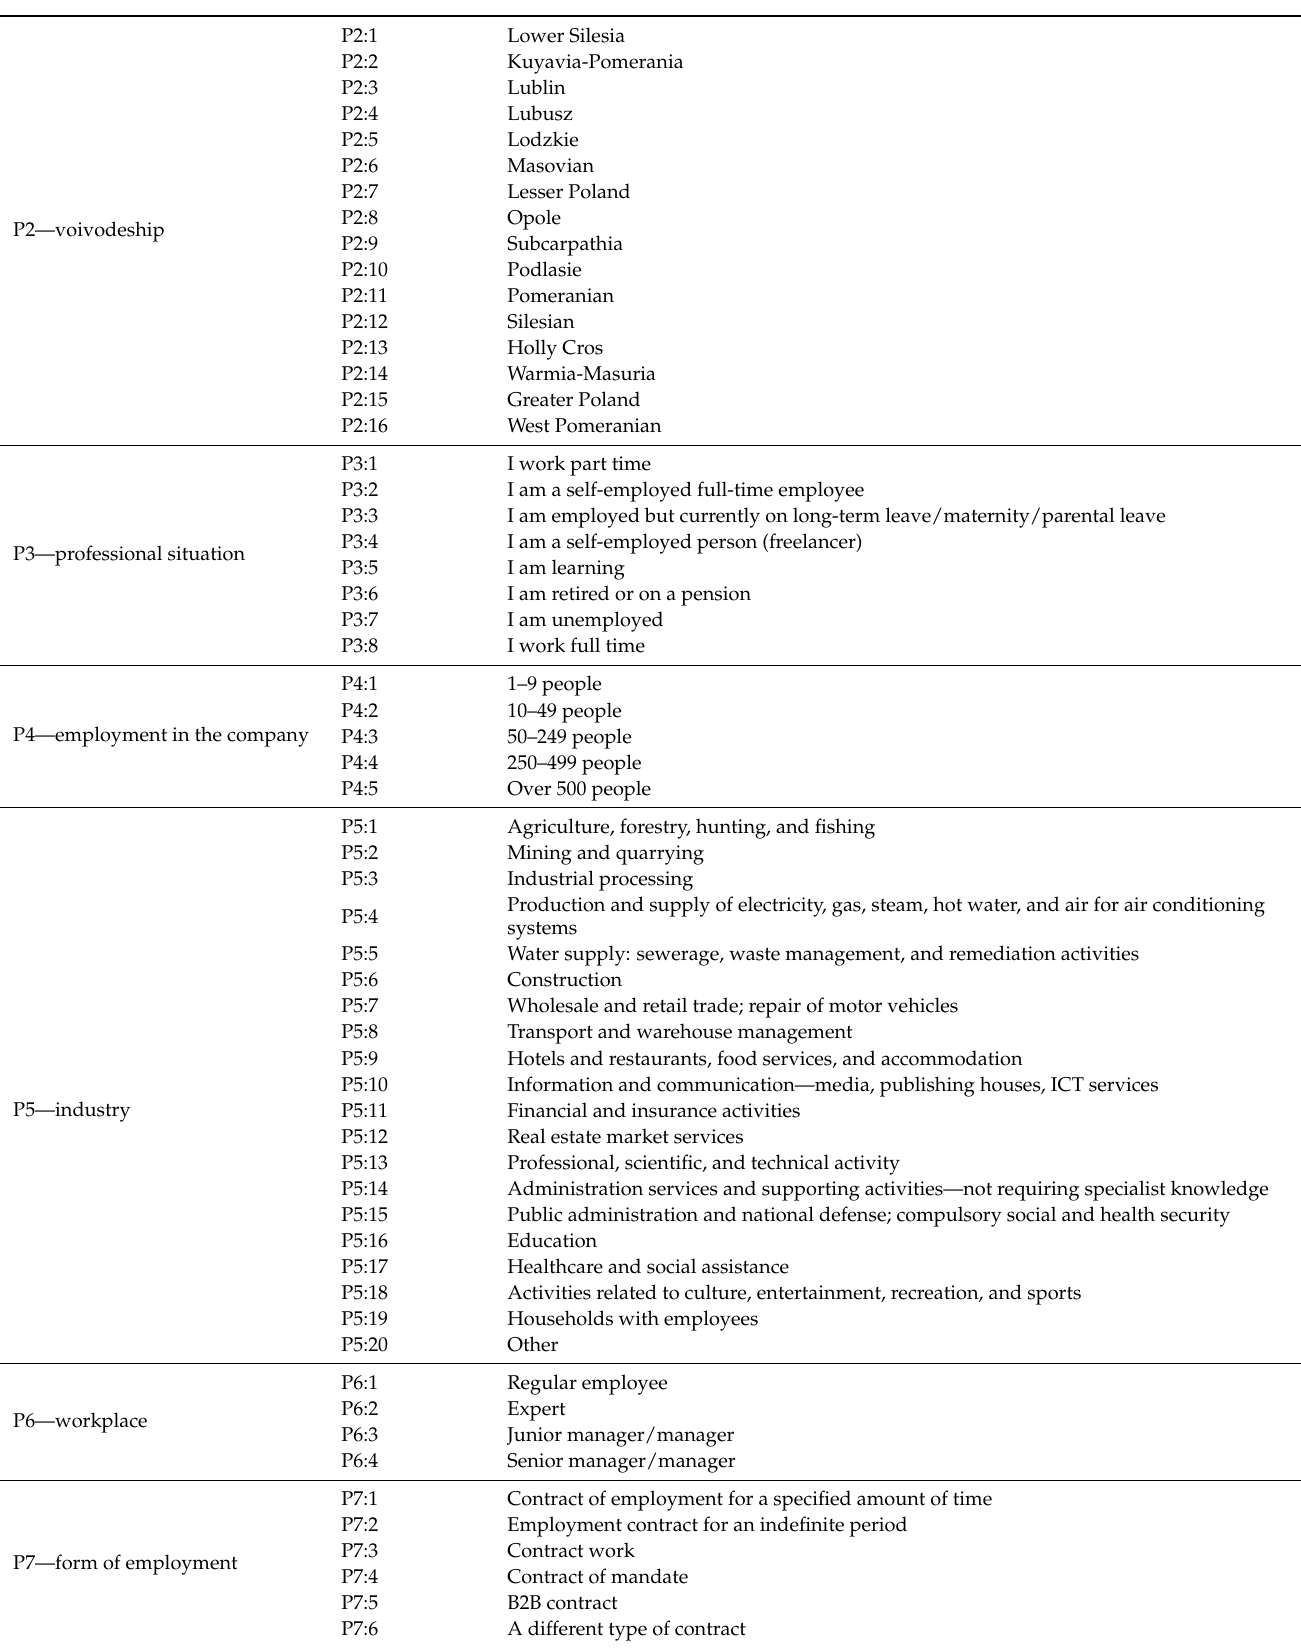
Table 2. Variables used in the analysis—characteristics of the